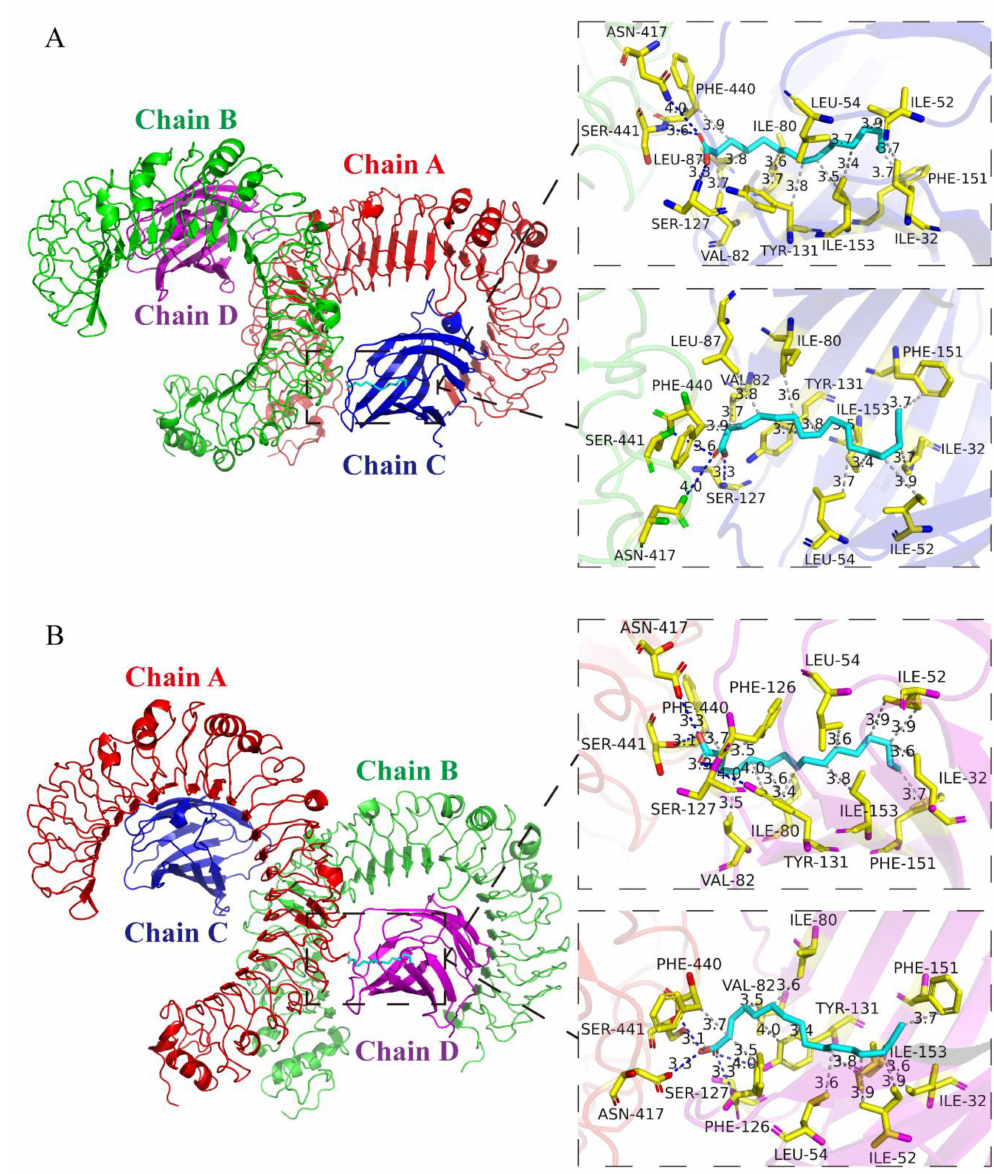
Figure 2. Molecular docking between PA and TLR4 Four chains of TLR4 are shown as multicolor bands. PA is shown as cyan sticks and TLR4 residues are marked with yellow sticks. ( A ) The image shows the docking pose, binding sites, and interactions between PA and the C-chain of TLR4. There were three hydrogen bonds between PA and the TLR4 protein residues, which were Ser-127 at 3.3 Å, Asn-417 at 3.6 Å, and Ser-441 at 3.6 Å. In addition, PA and TLR4 also formed 12 hydrophobic interactions in the C-chain, which were Ile-32 at 3.75 Å, Ile-52 at 3.93 Å, Leu-54 at 3.72 Å, Ile-80 at 3.60 Å, Val-82 at 3.73 Å, Leu-87 at 3.77 Å, Tyr-131 at 3.81 Å, Tyr-131 at 3.73 Å, Phe-151 at 3.66 Å, Ile-153 at 3.36 Å, Ile-153 at 3.54 Å, and Phe-440 at 3.88 Å. ( B ) Docking pose, binding sites, and interactions between PA and D-chain of TLR4. PA formed four hydrogen bonds with the TLR4 protein residues in the binding pocket of the D-chain, which were Ser-127 at 2.33 Å, Tyr-131 at 3.97 Å, Asn-417 at 3.00 Å, and Ser-441 at 2.25 Å. PA and the TLR4 protein residues formed 12 hydrophobic interactions in the binding pocket of the D-chain, which were Ile-32 at 3.57 Å, Ile-52 at 3.87 Å, Ile-52 at 3.94 Å, Ieu-54 at 3.57 Å, Ile-80 at 3.58 Å, Val-82 at 3.53 Å, Phe-126 at 3.5 Å, Tyr-131 at 3.4 Å, Tyr-131 at 3.95 Å, Phe-151 at 3.7 Å, Ile-153 at 3.8 Å, and Phe-440 at 3.73